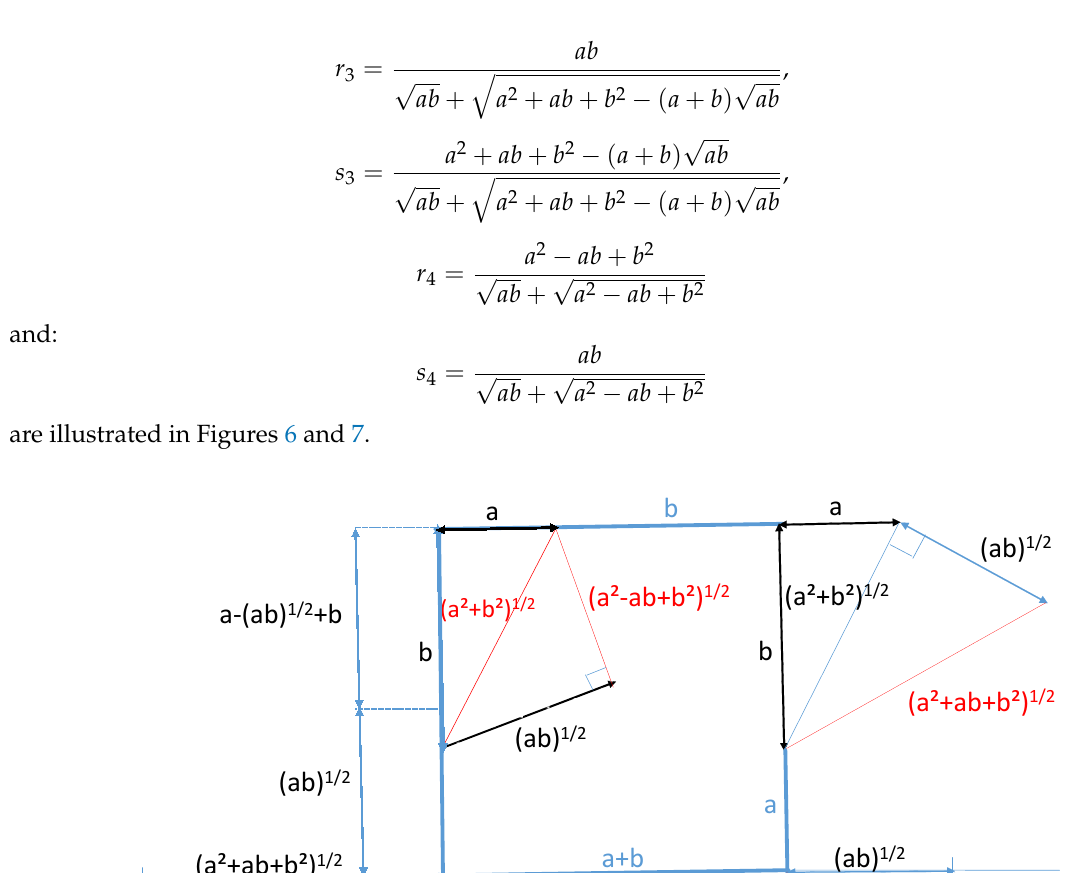
√ √ √ (cid:113) ( a + b ) a 2 + b 2 , a 2 ± ab + b 2 , ab and ab + b 2 ; and (cid:6) 14